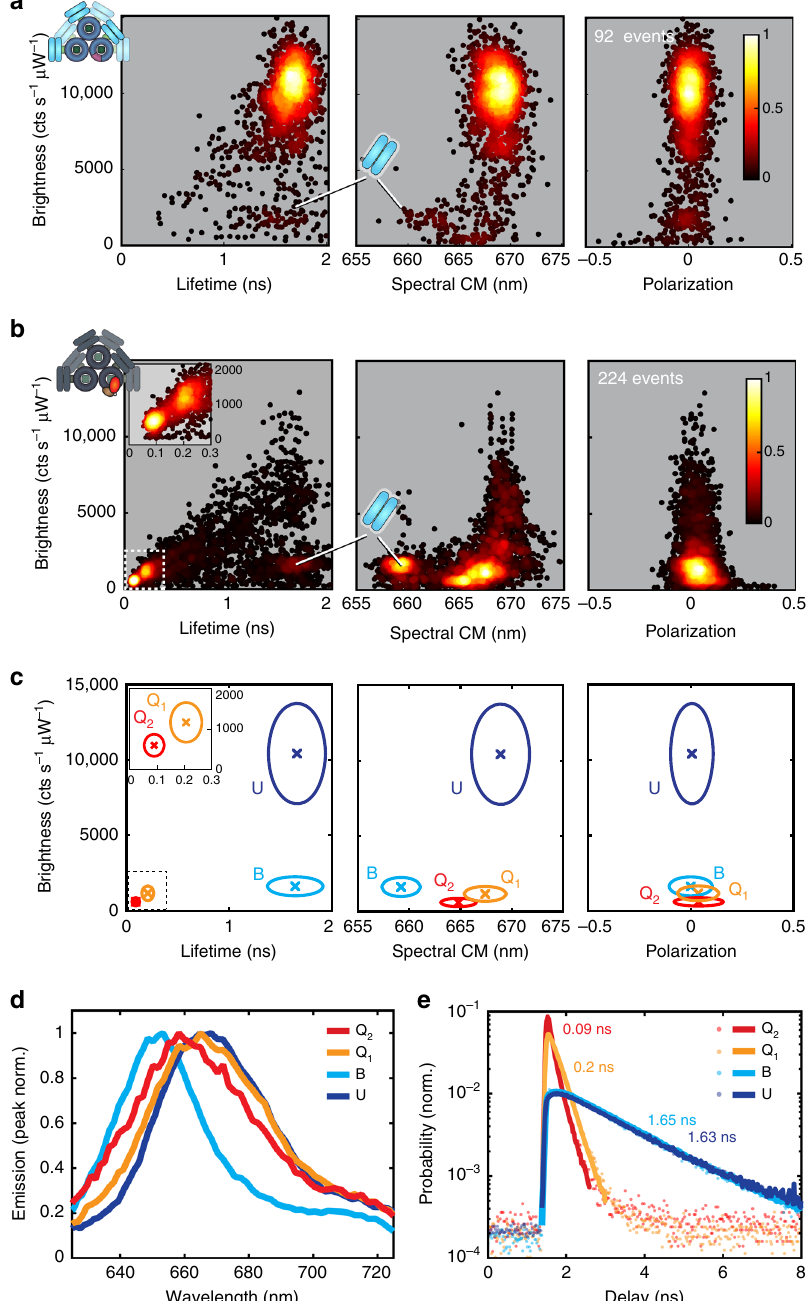
Fig. 3 Photophysical states of unquenched and OCP-quenched CB-PB Phycobilisomes. a Scatter heatmap of the photophysical state (U) observed for the unquenched CB-PB phycobilisome, shown in Br - τ , Br- λ CM , and Br-FPol projections (left, right, and center, respectively). Each point represents 500 photons, colored according to the normalized local density of points for each panel (see colorbar). The location of state B, very rarely observed here, is also indicated for reference. b Scatter heatmap of photophysical states (B, Q 1 , and Q 2 ) observed for the sample containing OCP-quenched CB-PB phycobilisome, shown in Br- τ , Br- λ CM , and Br-FPol projections (left, right, and center, respectively). Each point represents 500 photons, colored according to the normalized local density of points for each panel (see colorbar). c Summary map of observed photophysical states U, B, Q 1 , and Q 2 , each depicted by the population mean (x) and 95% con fi dence ellipse. d Fluorescence emission spectra associated with each photophysical state. e Collective fl uorescence lifetime decay and single-exponential maximum likelihood fi t for each photophysical